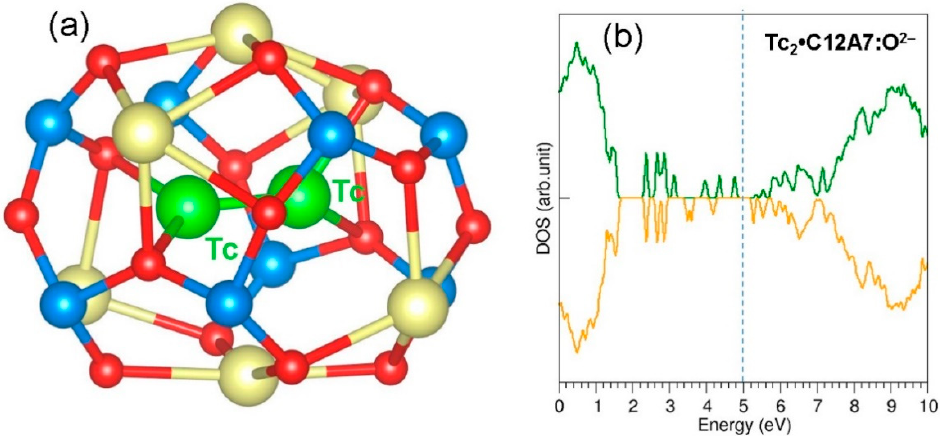
Figure 6. ( a ) Relaxed cage structure showing the accommodation of the Tc dimer in C12A7:O 2 − and ( b ) DOS plot calculated for Tc 2 : C12A7:O 2 − .